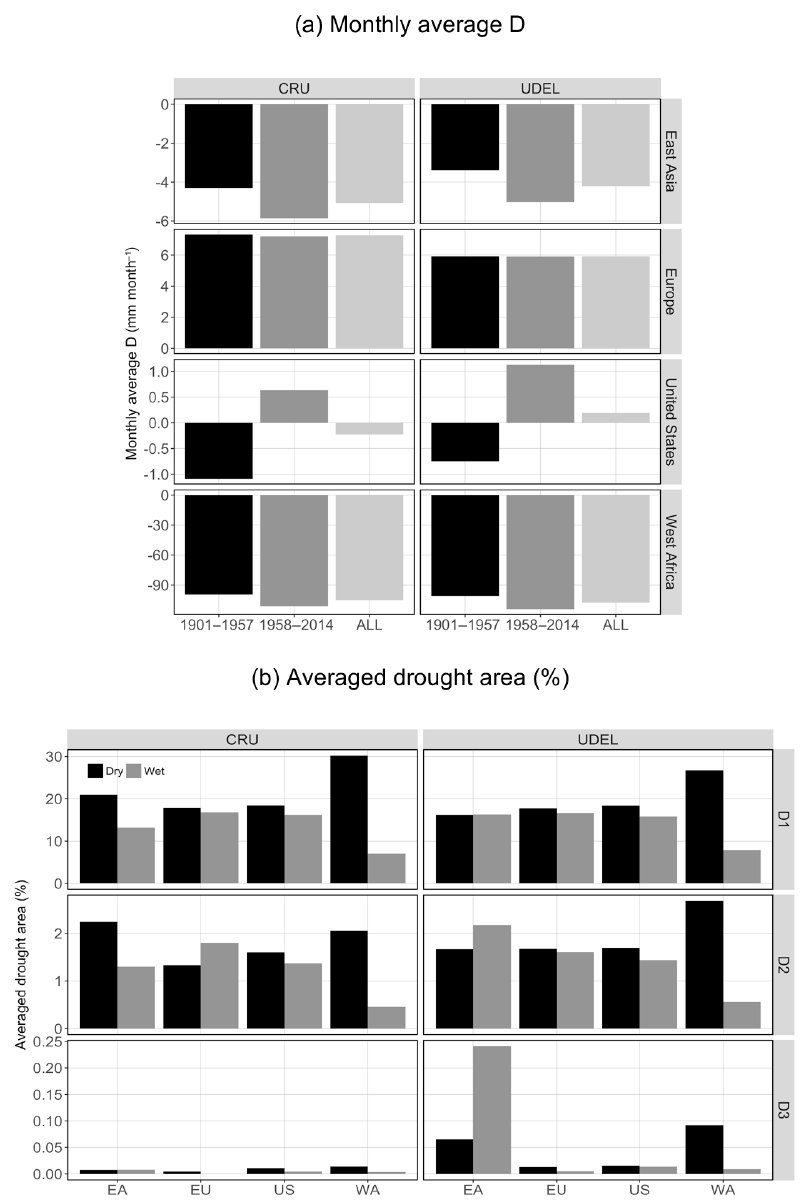
Figure 12. Monthly average surplus or deficit ( D ; mm) in Eq. (1) and average drought area (%) based on the CRU and UDEL datasets in East Asia (EA), Europe (EU), the United States (US) and West Africa (WA) regions for the Ref1 condition. In (a) , ALL denotes the period of 1901–2014. In (b) , Dry denotes that the monthly average D in the assessment period is less than that in the reference period, and Wet denotes that the monthly average D in the assessment period is greater than that in the reference period based on the Ref1